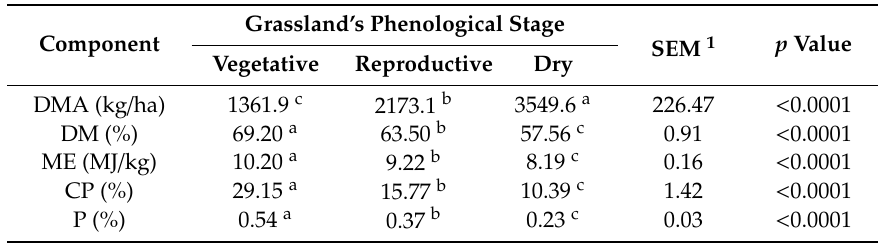
Table 1. Dry matter availability (DMA), digestibility (DM), metabolizable energy (ME), crude protein (CP) and phosphorus (P) concentration in the grassland, at di ff erent phenological